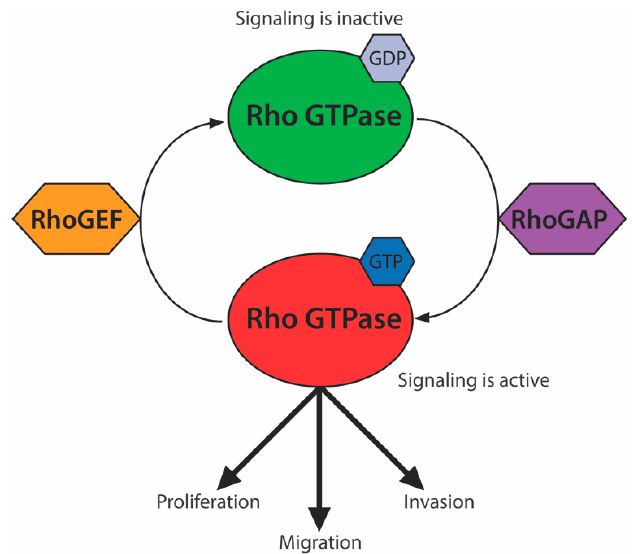
Figure 1. The Rho GTPase signaling module. Rho GTPases (red) are active while bound to GTP. Rho GTPase-activating proteins (RhoGAPs) (purple) stimulate hydrolysis of bound GTP, switching Rho GTPases to an inactive GDP-bound state. Rho guanine nucleotide exchange factors (RhoGEFs) (orange) exchange bound GDP for GTP, reactivating Rho GTPase signaling, which promotes cellular proliferation, migration, and invasion.